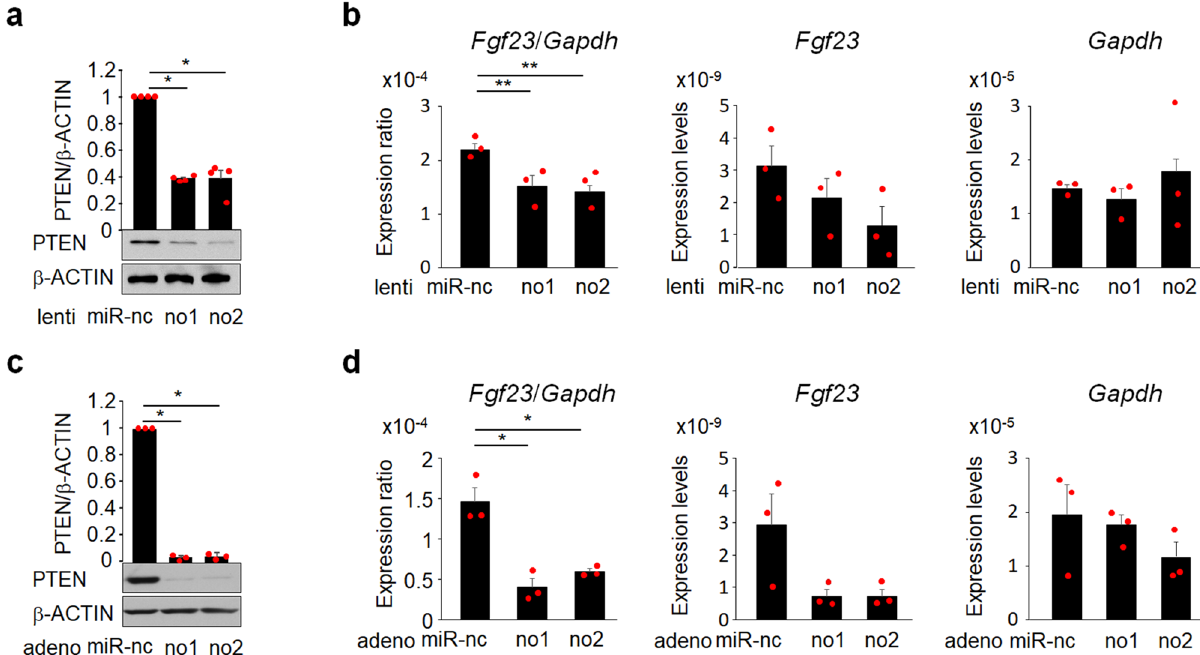
Figure 4. The lack of PTEN in UMR106 cells suppresses Fgf23 expression. ( a ) and ( b ) The expression of PTEN was knocked down using a lentivirus and knockdown efficacy was evaluated by a Western blot analysis for PTEN (N = 4) ( a ). The expression of Fgf23 and Gapdh was assessed by a real-time RT-PCR analysis and the expression ratio of Fgf23 / Gapdh was determined. Statistical analysis was performed after corrected for the expression of Gapdh . (N = 3) ( b ). ( c ) and ( d ). The expression of PTEN was knocked down using an adenovirus and knockdown efficacy was evaluated by a Western blot analysis for PTEN (N = 3) ( c ). The expression of Fgf23 and Gapdh was assessed by a real-time RT-PCR analysis and the expression ratio of Fgf23 / Gapdh was determined. Statistical analysis was performed after corrected for the expression of Gapdh . (N = 3) ( d ). Statistical analysis was performed using one-way ANOVA. * p < 0.01; ** p < 0.05, miR: microRNA, nc: negative